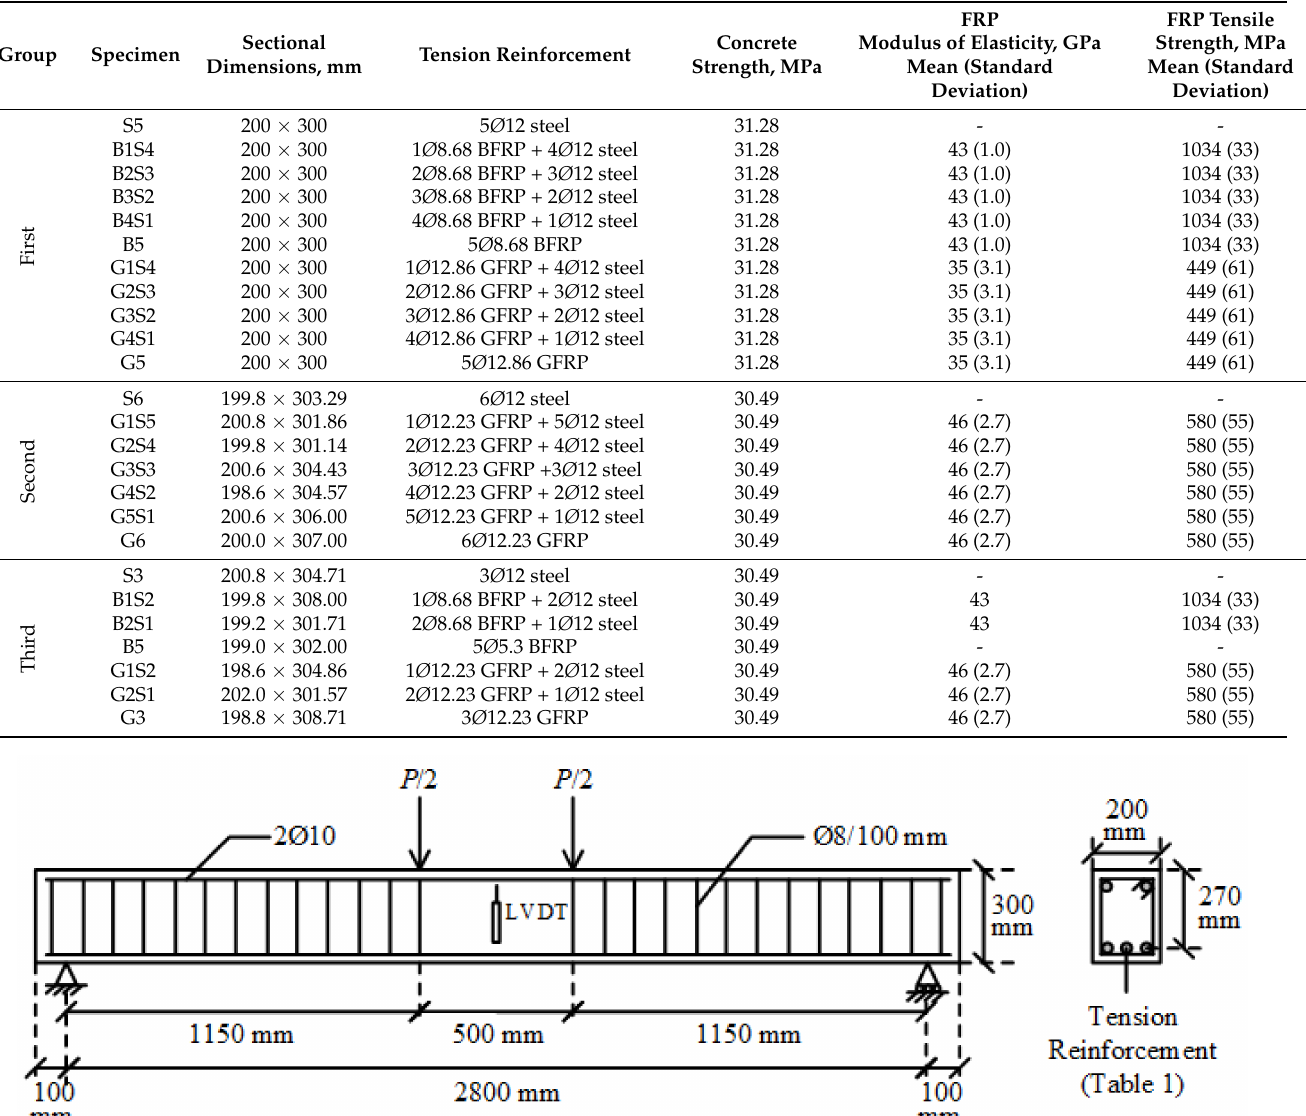
Table 1. Details and mechanical properties of the test beams.